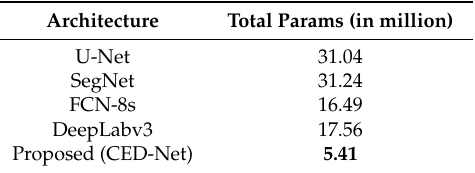
Table 2. Total number of parameters for di ff erent architectures (bold number represents the best results in the table).